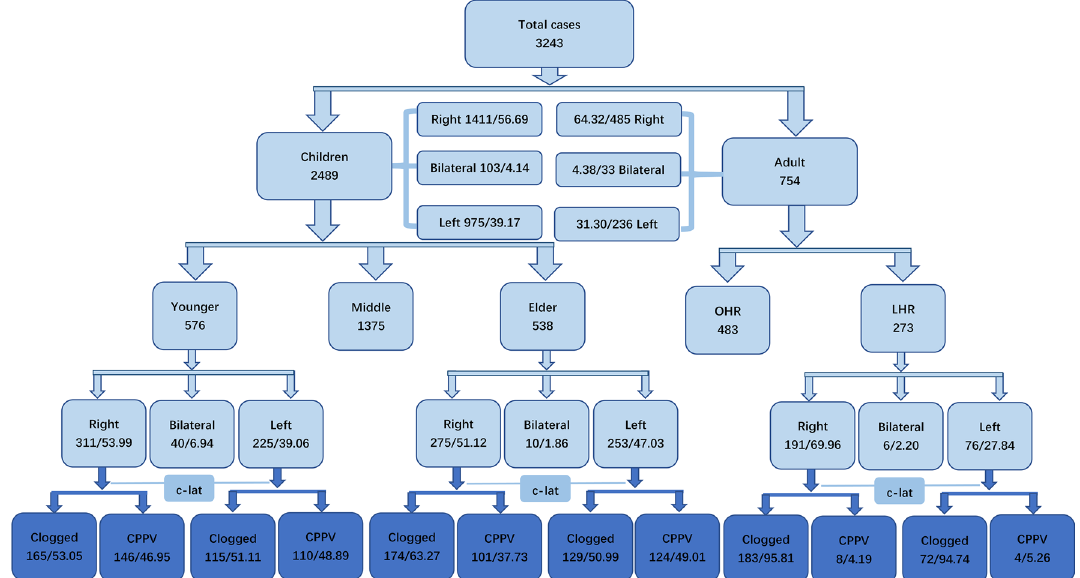
Figure 1. The incidence of CPPV in different groups. Younger: aged ≤ 18 months, older: aged ≥ 60 months, c-lat: